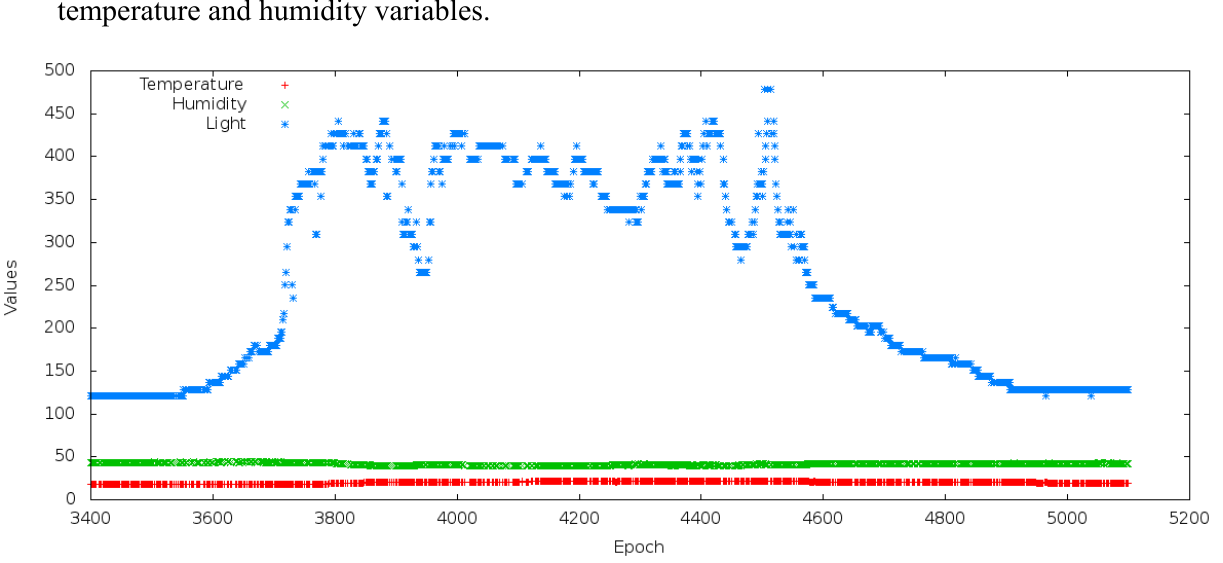
Figure 19. Epochs from a collect day where the light variable is less correlated with the temperature and humidity